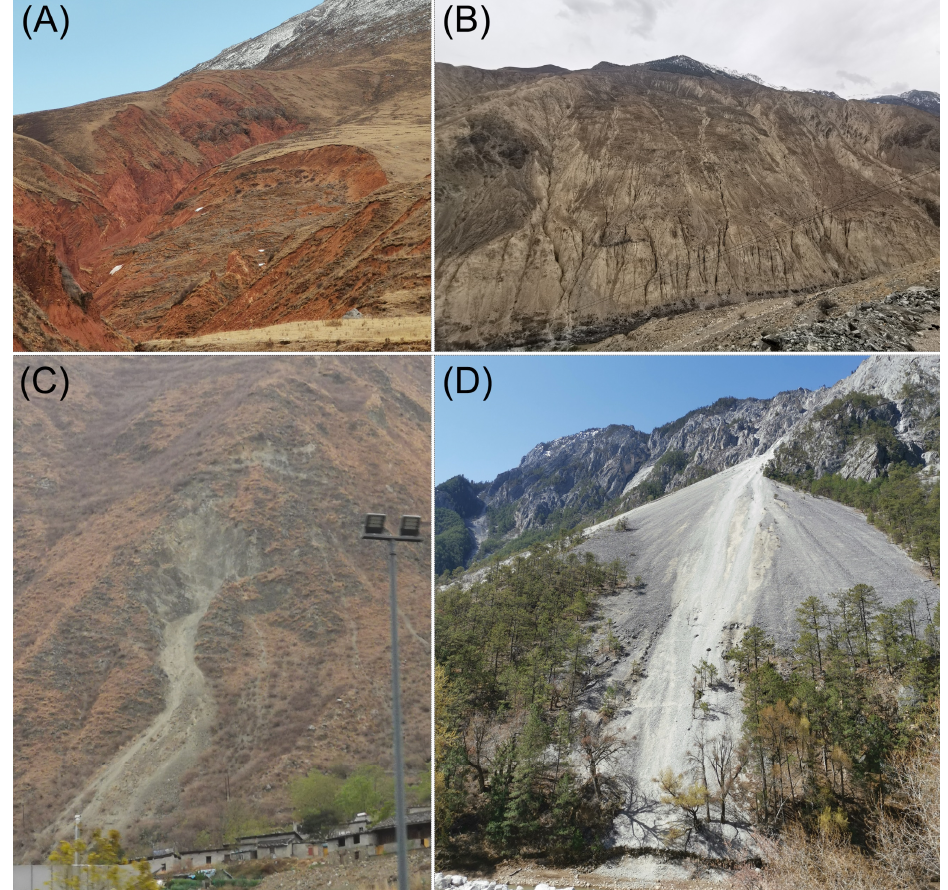
Figure 2. Photos of several typical landslides taken during field investigation: ( A ) shallow soil sliding; ( B ) old rockslide; ( C ) rock fall; ( D ) debris falling, sliding, and accumulating. Table 1. Sentinel-1 SAR images used in this